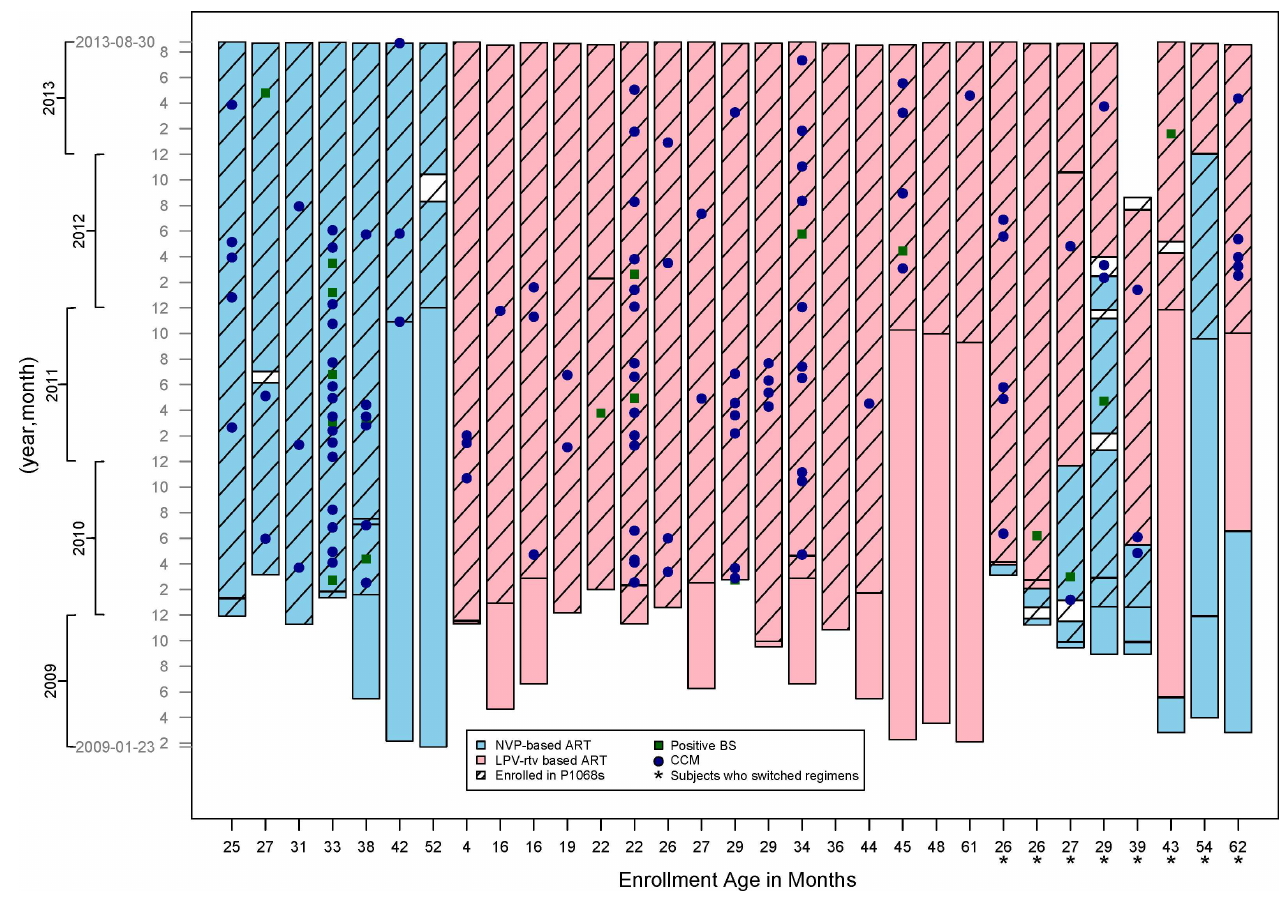
Fig 1. Graphic representation of patients enrolled in our substudy, P1068s,by sample date. Lopinavir-ritonavir based antiretroviral therapy (LPV-rtv ART) or NNRTI nevirapine-basedART (NVP ART) treatment regimenand outcomes of Positive Blood Smear (BS) and ConfirmedClinical Malaria (CCM) or are sorted youngestto oldest enrollment age on the x-axis. Asterisks ( * ) indicatesubjects whose regimenswent from NVP to LPV-rtv ART on study due to virologicfailure as dictated by the parent study, P1060.